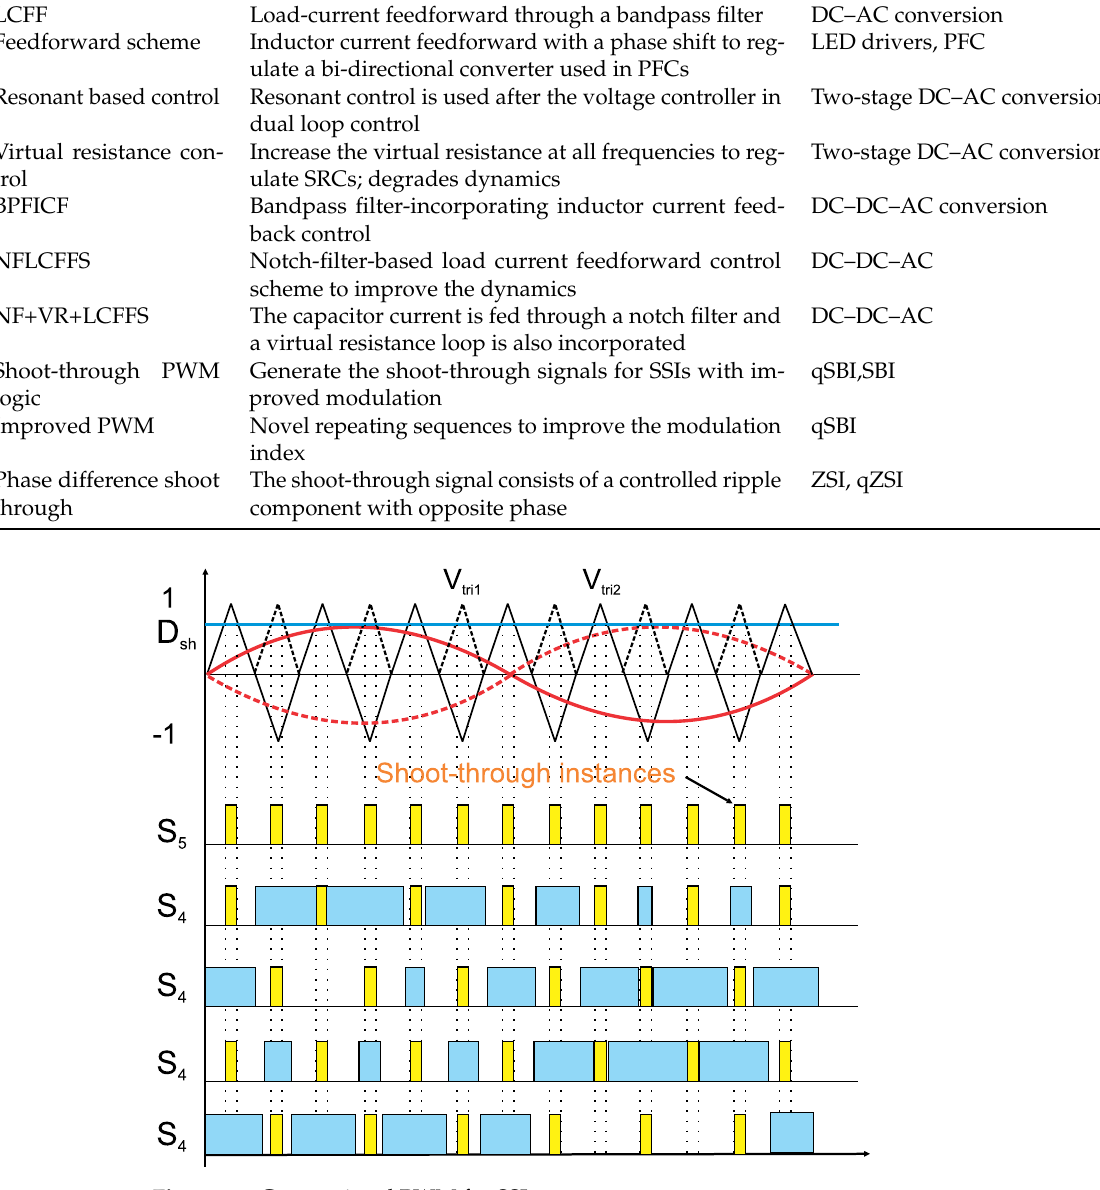
Figure 31. Conventional PWM for